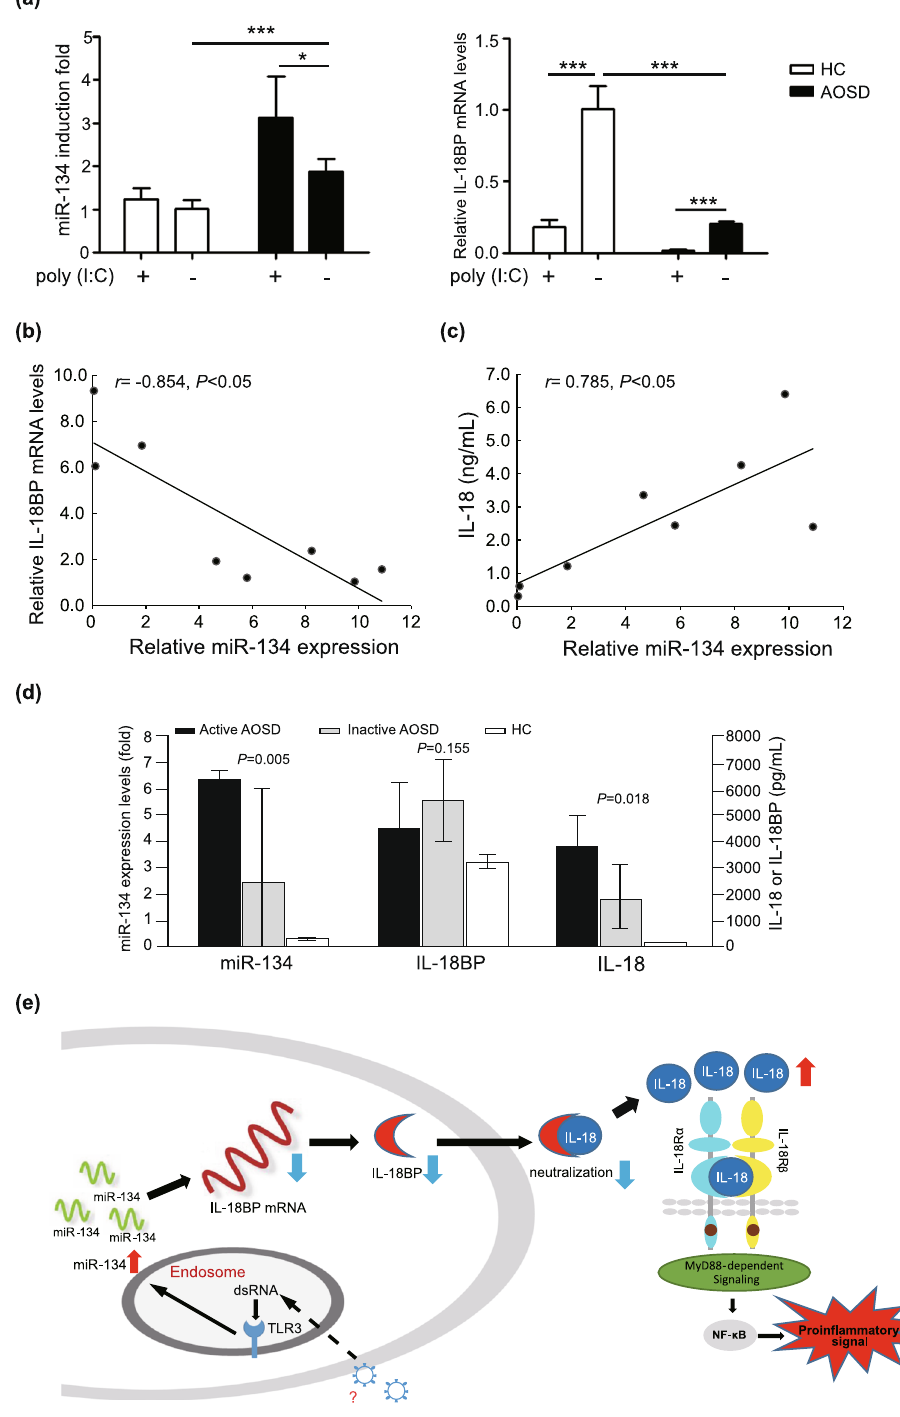
Figure 4. Toll-like receptor 3 (TLR3) ligand-induced miR-134 contributes elevated free interleukin-18 (IL-18) levels by targeting interleukin-18 binding protein (IL-18BP). ( a ) TLR3 ligand poly (I:C) stimulation induced miR-134 up-regulation (left panel), caused significantly reduced IL-18BP mRNA levels (right panel) in PBMCs from AOSD patients or healthy controls (HC). Data are presented as mean ± SEM. * P < 0.05, *** P < 0.005. Correlation between miR-134 expressions and IL-18BP mRNA levels ( b ) or IL-18 levels ( c ) in AOSD patients is determined by Spearman’s correlation test. ( d ) Comparison of expression levels of miR-134, IL-18, and IL-18BP in active AOSD patients, inactive AOSD patients, and HC. Data are presented as mean ± SEM. ( e ) Proposed model for the biologic role of miR-134 in increased level of free IL-18 by targeting IL-18BP in an inflammatory response of AOSD based on the results of this study and previous reports. MyD88, myeloid differentiation primary-response protein 88; NF-ĸB, nuclear factor